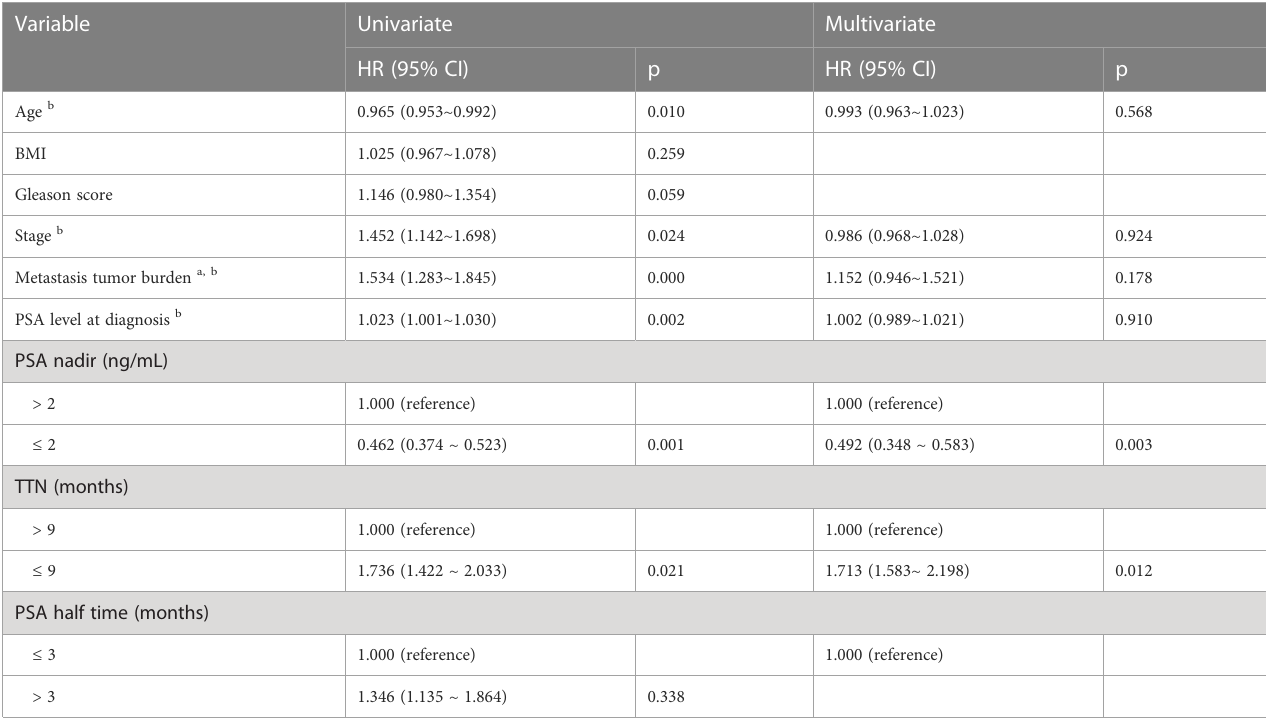
TABLE 2 Univariate and multivariable analysis of potential risk factors for biochemical progression-free survival. Variable Univariate